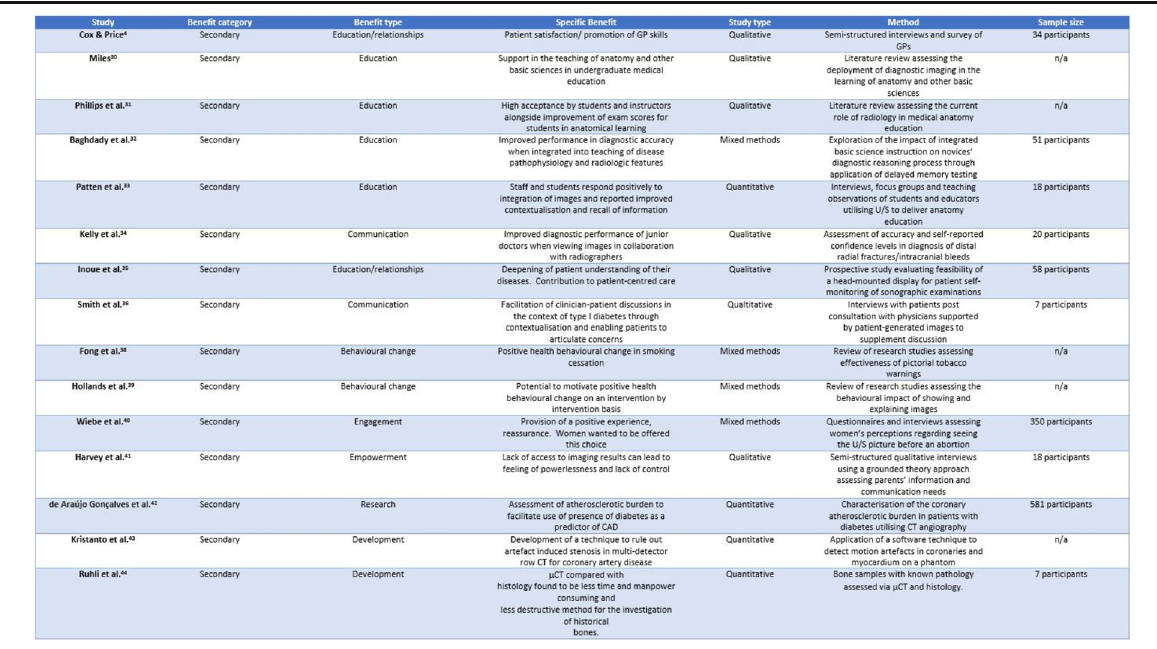
Table 3 An overview of study types and contents and the secondary benefit categories